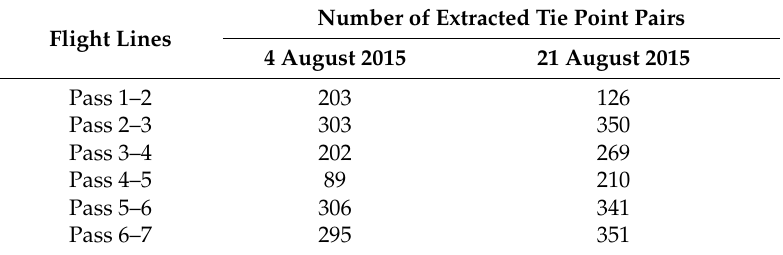
Table 2. Number of identified tie point pairs between neighboring partially-rectified hyperspectral orthophotos.